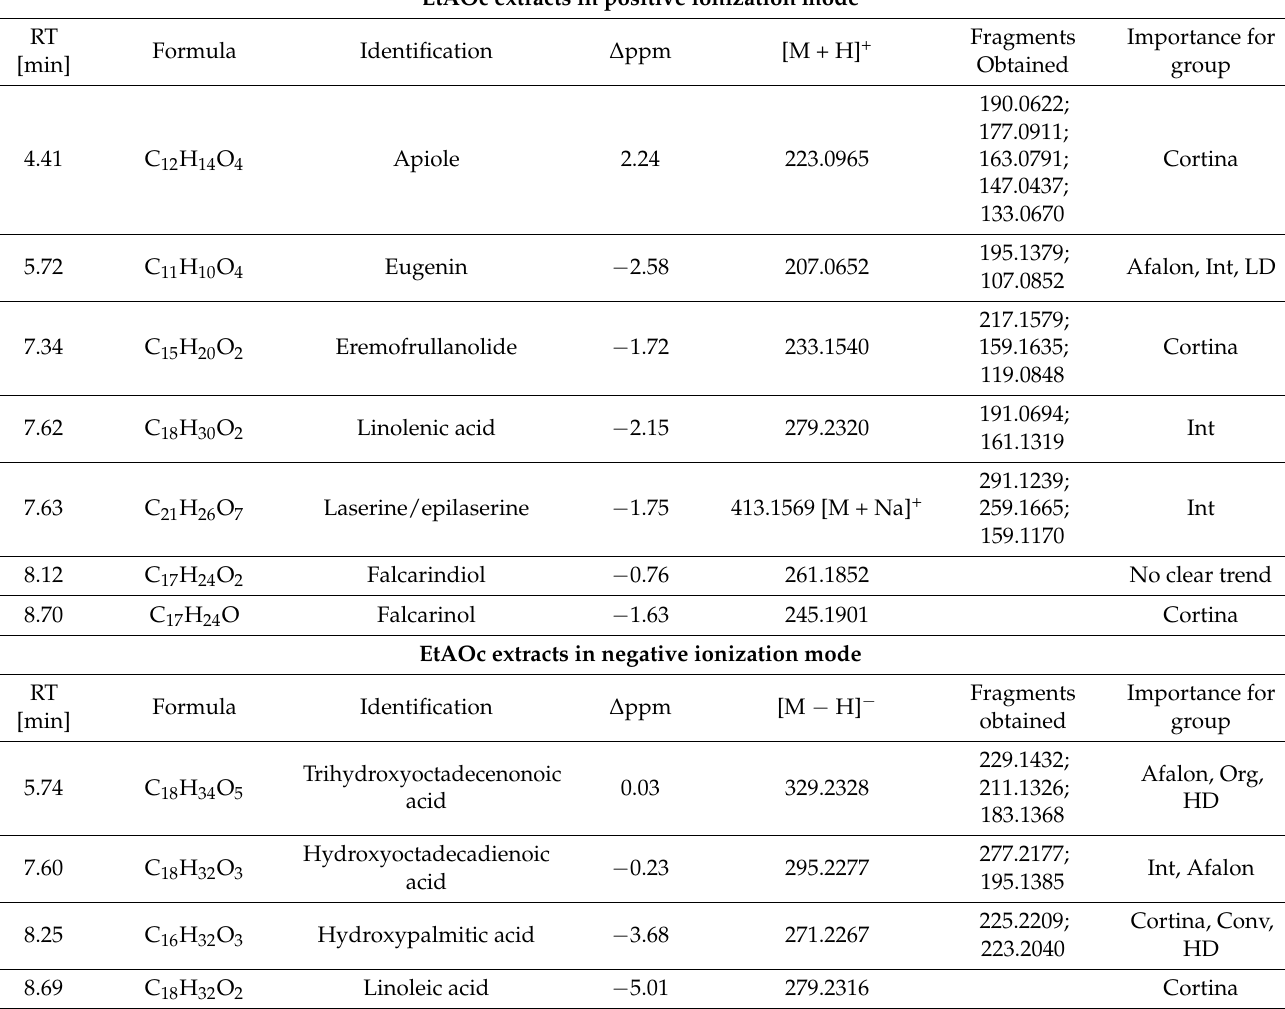
Table 3. List of compounds identified by UHPLC–Q-TOF-MS used for metabolomic analysis of carrot samples (ethylacetate extracts). The compounds are sorted according to their retention time. (Conv = conventional, int = integrated, org = organic, LD = low seeding density, 6 × 10 5 seeds per ha, HD = high seeding density, 9 × 10 5 seeds per